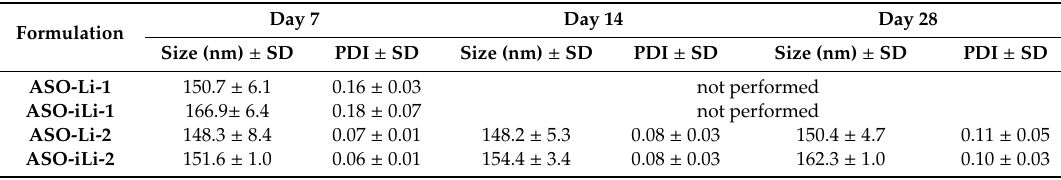
Table 2. Size and PDI comparison over time for formulation 2.